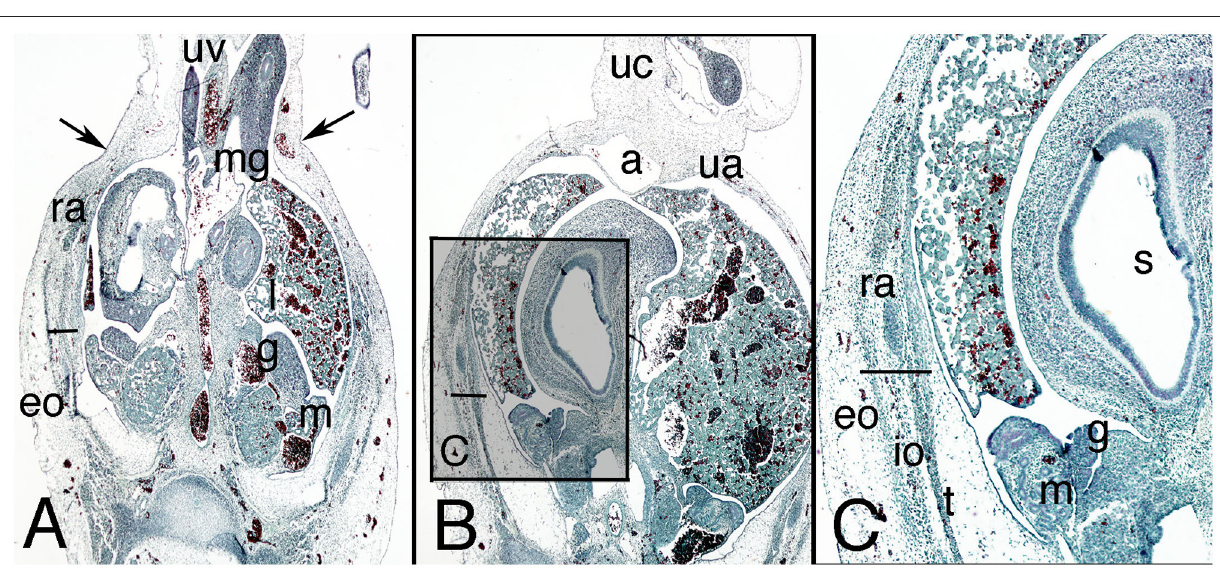
FIGURE 2 | Cross section of embryo C-7 (stage 18) at abdominal level. Hematoxylin and eosin staining. (A) (2X) umbilical physiological hernia level; (B) (2X) infra-umbilical level; (C) (4X) box of (B) , showing detail of the left abdominal wall. a, alantois; eo, external oblique muscle; g, gonad; h, middle gut; io, internal oblique muscle; l, liver; m, mesonephros; mg, middle gut, ra, rectus abdominis; s, stomach; t, transversus abdominis muscle; ua, umbilical artery; uc, umbilical cord; uv, umbilical vessels. Bar, common mass of the internal and transversus abdominis muscles; arrows, neck of the umbilical